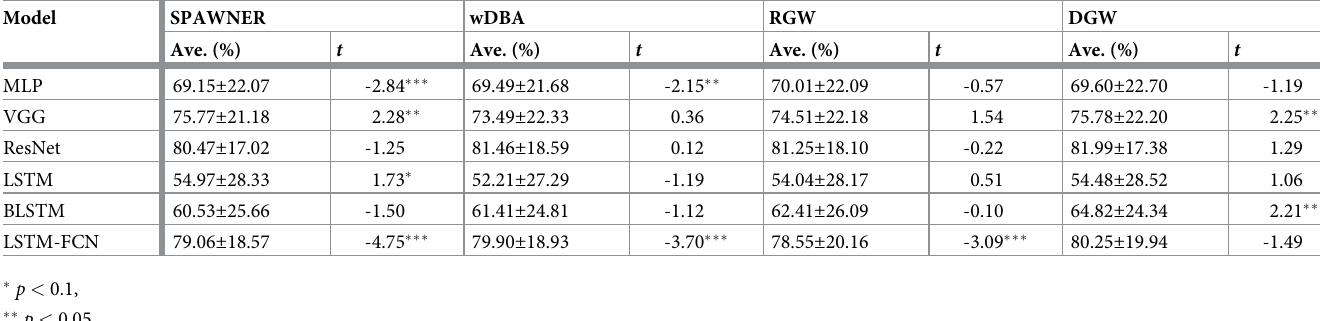
Table 3. Comparative results for pattern mixing-based data augmentation methods. Model